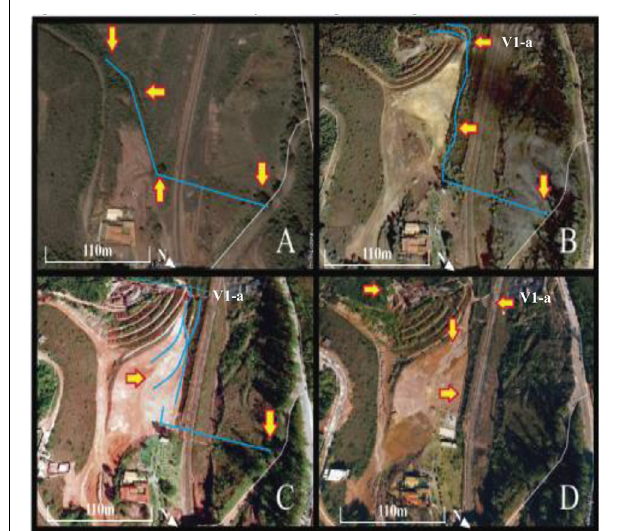
FIGURE 8 | Satellite image history indicating the emergence of the V1-a incision. (A) Arrows show the drainage channel in 2002 (B) arrows show channel reconfigured due to the construction of the waste landfill in 2008. (C) Presence of water traces on the surface of the waste landfill plateau indicating the direction of the water flow in 2009. (D) Intensification of the erosion processes in 2011. Source: Adapted from Google Earth,